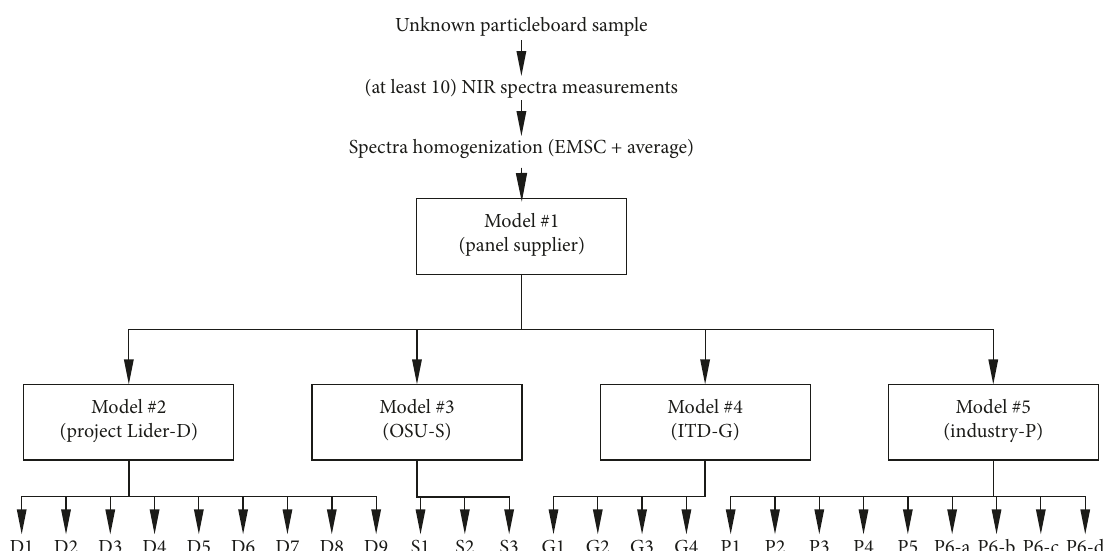
Figure 3: Prototype expert system’s layout for the experimental set of particleboard